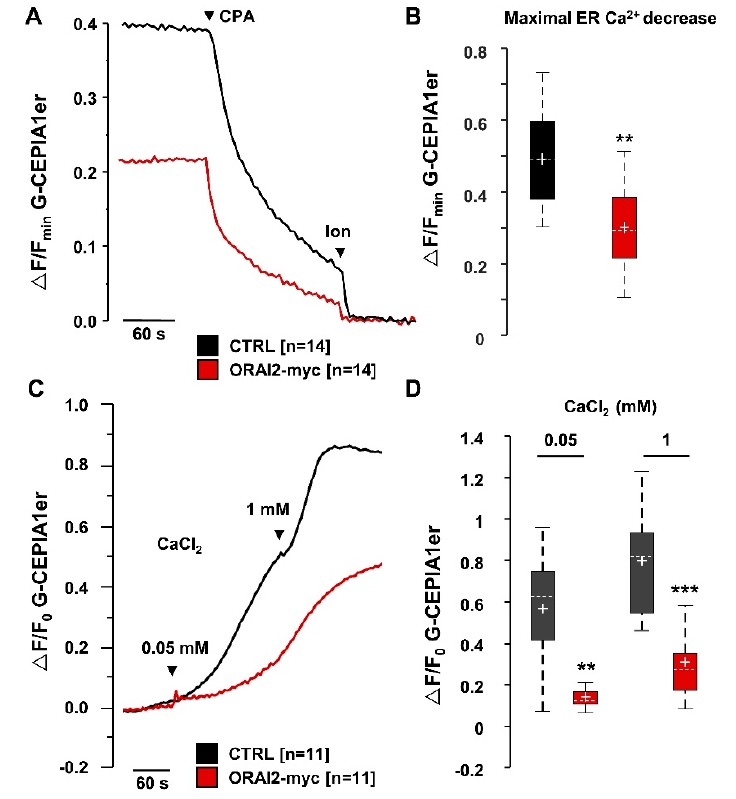
Figure 4. ORAI2-myc overexpression decreases the ER Ca 2 + content and refilling process. HeLa cells were co-transfected with the cDNAs coding for ORAI2-myc or with the void-vector (CTRL) and G-CEPIA1er in a 4:1 ratio. ( A,B ) Cells were bathed for two minutes in Ca 2 + -free mKRB, containing EGTA (0.6 mM), then challenged with CPA (20 µ M) and ionomycin (Ion, 1 µ M), where indicated by the arrows. ( A ) Representative traces of G-CEPIA1er fluorescence (F) normalized to the value measured after ionomycin addition (F min ) and expressed as ( ∆ F / F min ). ( B ) Boxplots of the maximal ER-Ca 2 + decrease ( ∆ F / F min ) obtained upon CPA and ionomycin addition, an indication of the ER Ca 2 + content ( n = 14, number of coverslips for each condition, from three independent cell batches, Wilcoxon-Mann-Whitney test ** p < 0.01). ( C,D ) Cells were pre-depleted with CPA (20 µ M) in Ca 2 + -free mKRB, containing EGTA (0.6 mM). Upon CPA washing, cells were exposed to an intracellular solution containing EGTA (50 µ M). Cells were permeabilized for 20 s with digitonin (100 µ M) and store refilling was induced by CaCl 2 addition in the presence of ATP (100 µ M). ( C ) Representative traces of the maximal fluorescence changes ( ∆ F) normalized to the initial basal level (F 0 ). ( D ) Boxplots of ∆ F / F 0 measured upon CaCl 2 addition, a rough estimate of the ER Ca 2 + concentration ( n = 11, number of coverslips from three independent cell batches, Wilcoxon-Mann-Whitney test, ** p < 0.01; *** p < 0.001).